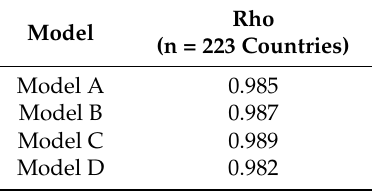
Table 2. Correlation between the ‘total service gap’ and ‘at least basic